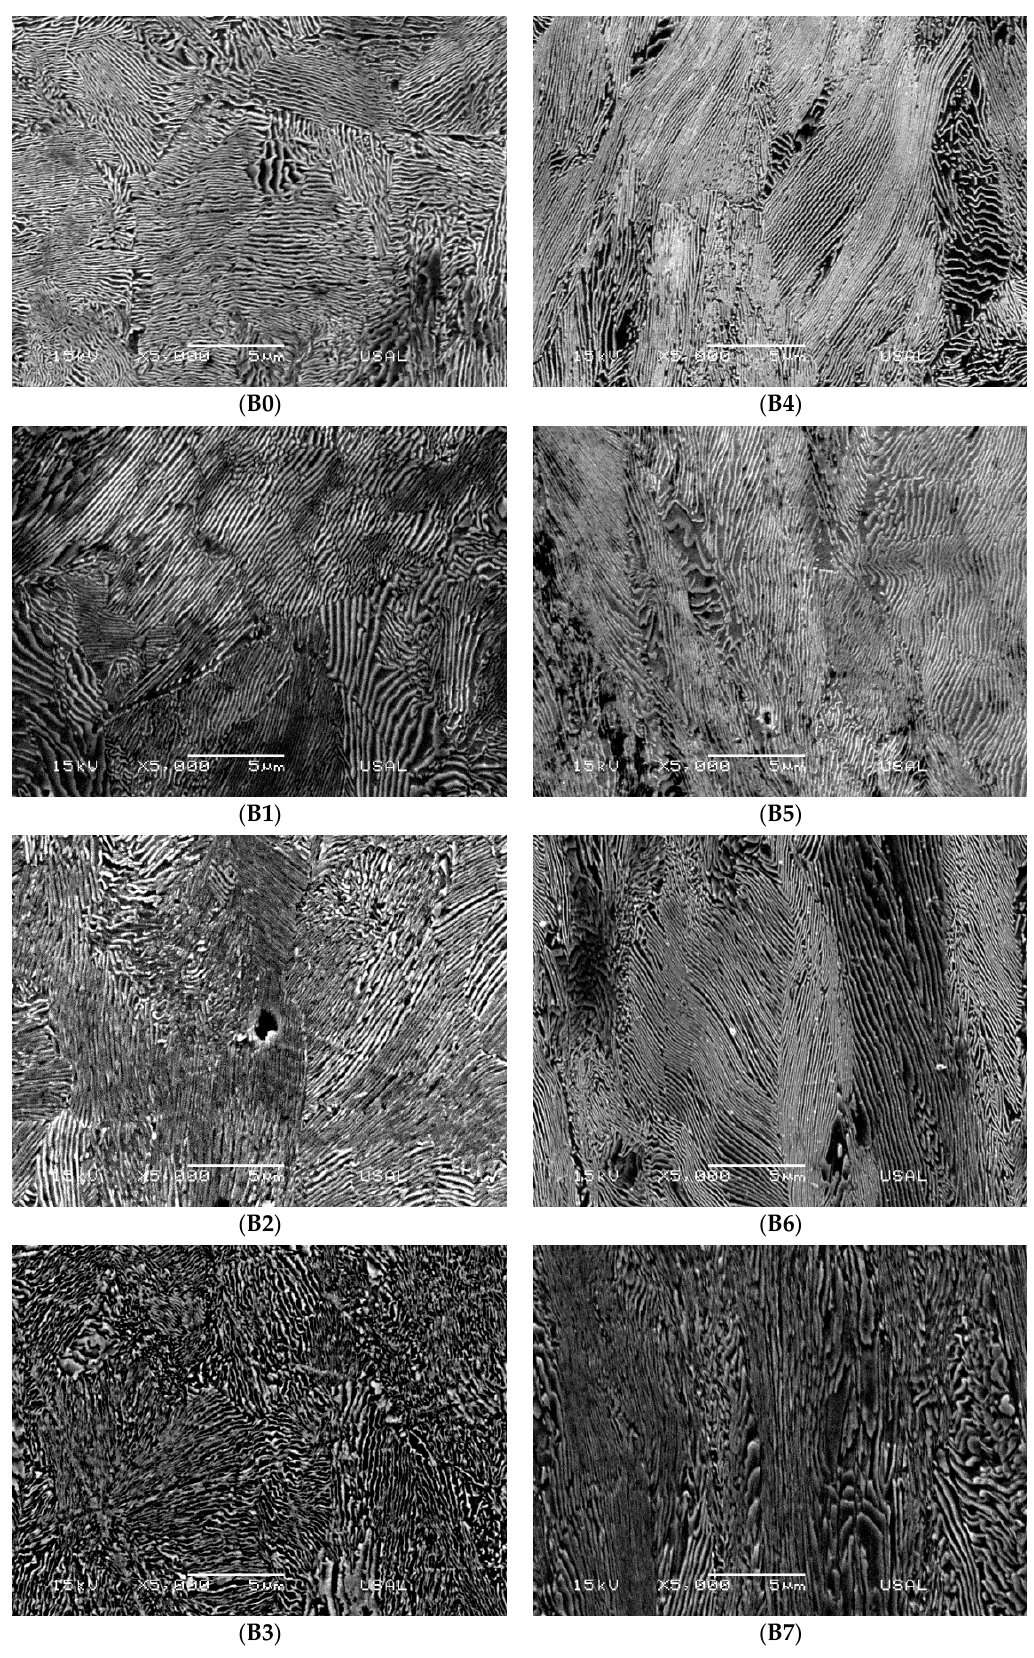
Figure 2. Metallographic analysis of the longitudinal section of family B for diverse drawing steps.